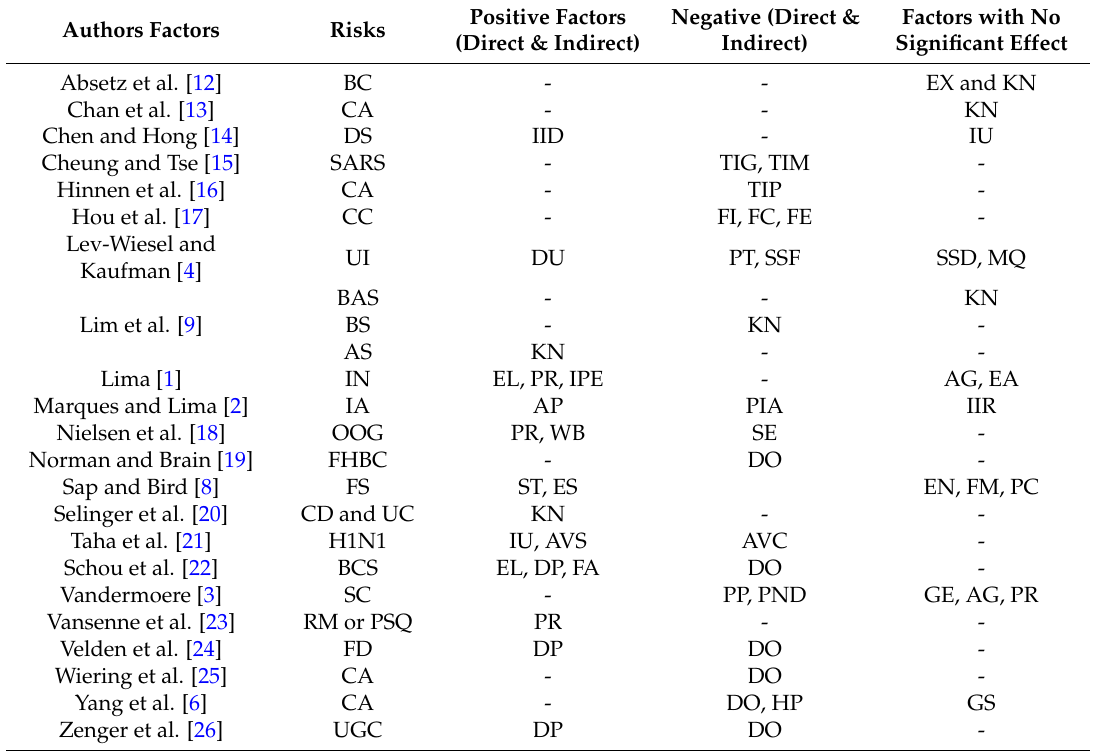
Table 1. Review of determinants of anxiety among people at